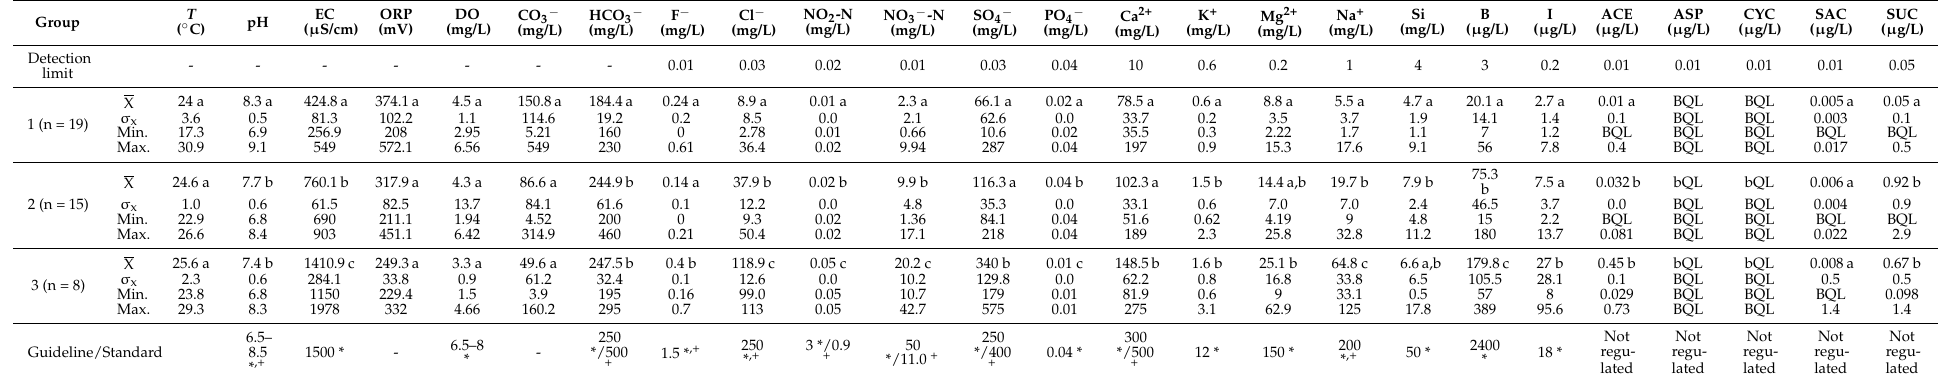
Table 1. Descriptive statistical summary of physicochemical parameters, major ions, and artificial sweeteners for MMA groundwater (mean (x), standard deviation ( σ x ), minimum (Min.), and maximum (Max.)